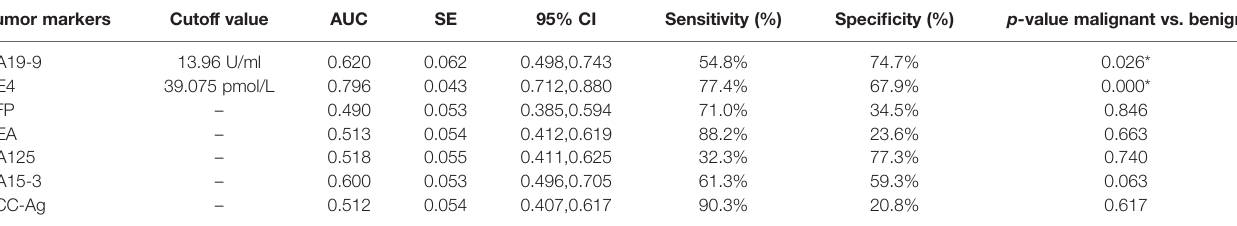
TABLE 6 | Expression of serum molecular markers of carcinoma in benign and malignant endometrium lesions. Tumor markers